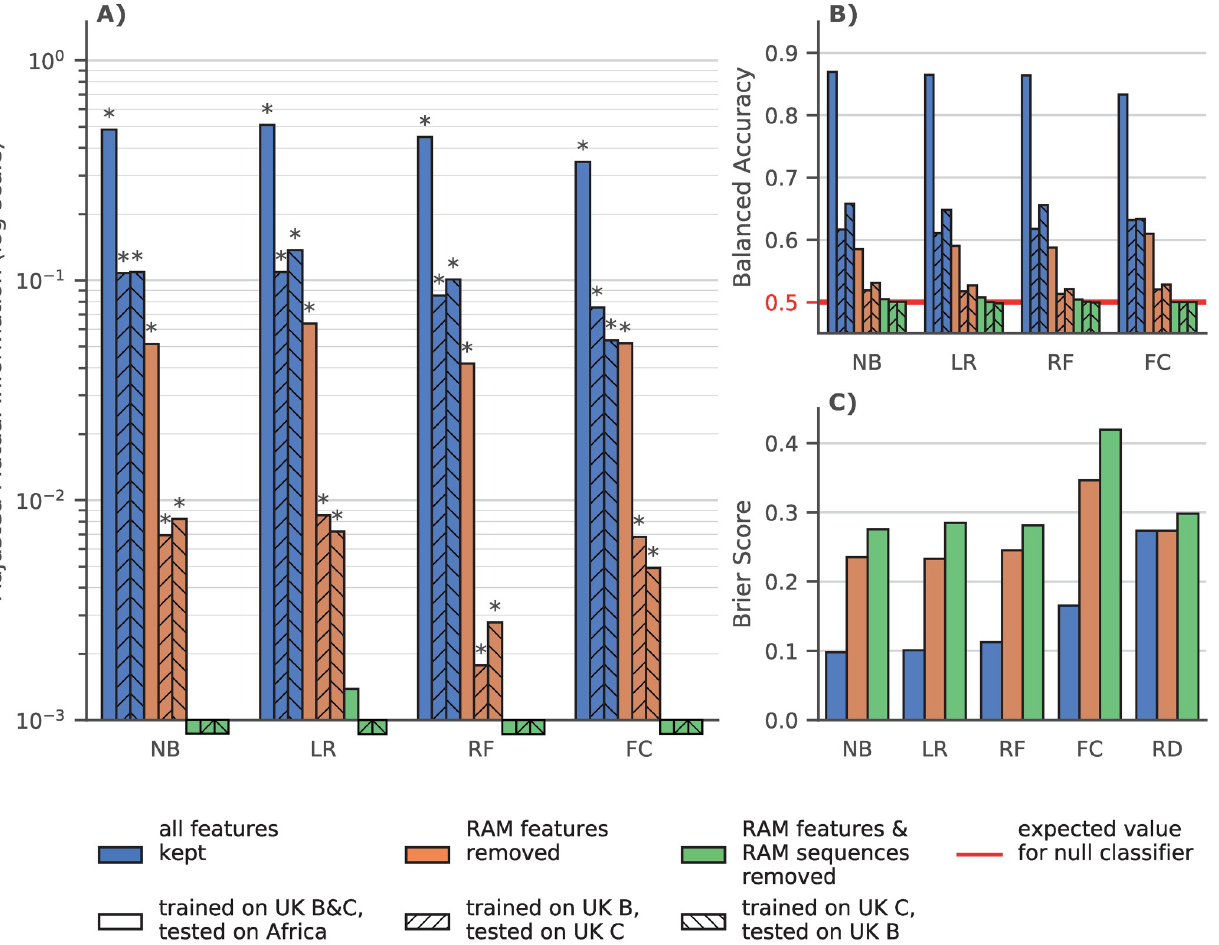
Fig 1. Classifier Performance on UK and African datasets. NB : naive Bayes, LR : Logistic Regression with Lasso regularization, RF : Random Forest, FC : Fisher Classifier, RD : Agnostic random probabilistic classifier (this classifier predicts, as the probability of a sample belonging to a class, the frequency of that class in the training data). A) Adjusted mutual information (higher is better) between ground truth and predictions by classifiers trained on dataset with all features (blue), without features corresponding to known RAMs (orange) and without RAM features and without sequences that have at least 1 known RAM (green). Hatching indicates the training set on which a classifier was trained and the testing set on which the performance was measured. The expected value for a null classifier is 0, and 1 for a perfect classifier and a � denotes that the p-value derived from mutual information is � 0.05. For example when trained with all features all the classifiers have a significative MI. Conversely when removing RAM features and RAM sequences none of the classifiers have a significative MI and only LR trained on the entirety of the UK dataset has an AMI > 10 − 3 . B) Balanced Accuracy score, i.e. average of accuracies per- class (higher is better) for the same classifiers as in A). The red line at y = 0.5 is the expected balanced accuracy for a null classifier that only predicts the majority class as well as a random uniform (i.e. 50/50) classifier. C) Brier score, which is the mean squared difference between the sample’s experience to RTI and the predicted probability of being RTI experienced (lower is better), for the same classifiers as in A) and B) .